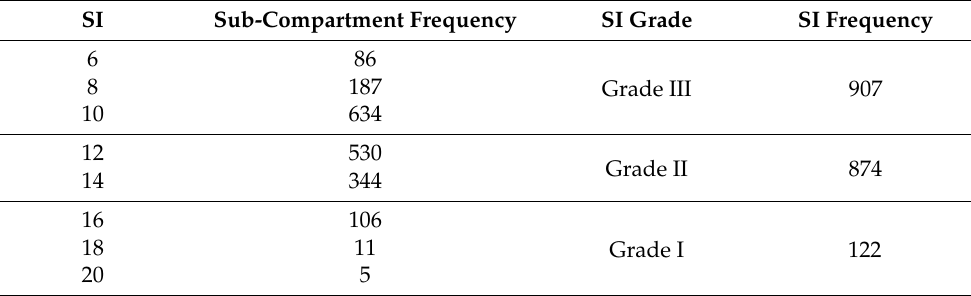
Table 2. The SI frequency distribution of the Chinese fir sub-compartments.